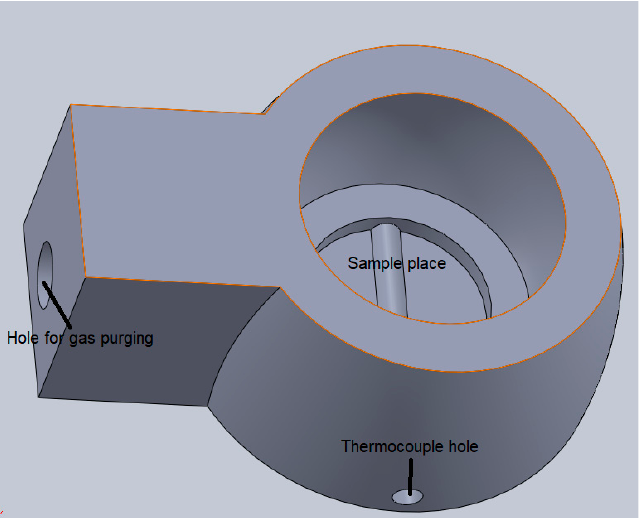
Figure 2. Ceramic crucible for sintering.